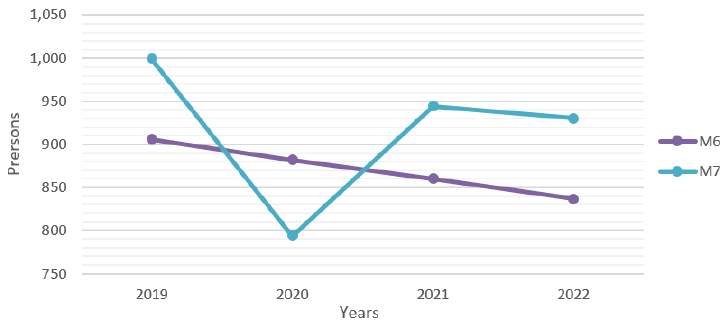
Figure 6. Models useful for combined forecasts (own elaboration).